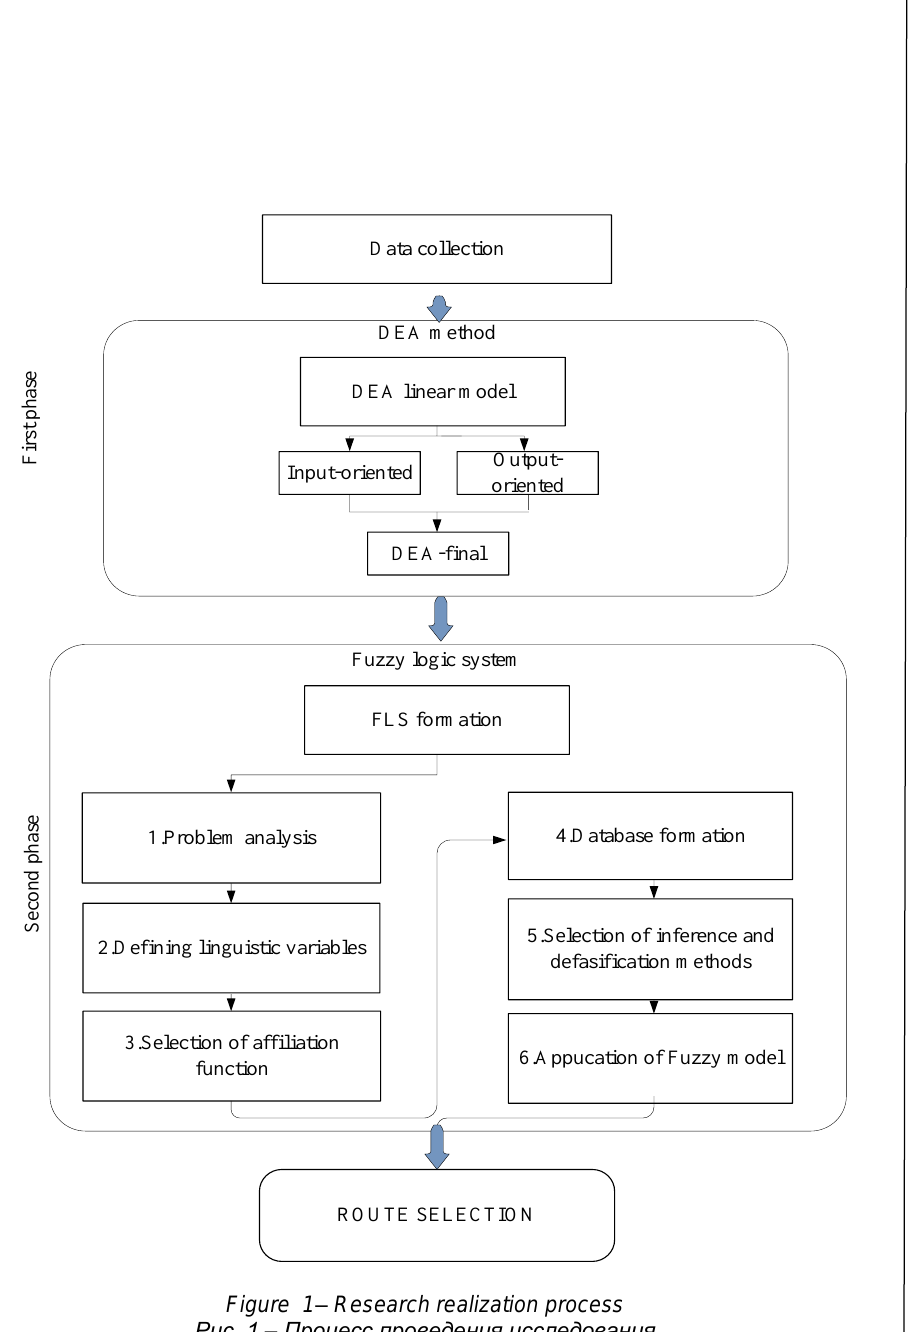
Figure 1– Research realization process Рис. 1 – Процесс проведения исследования Слика 1 – Процес реализације